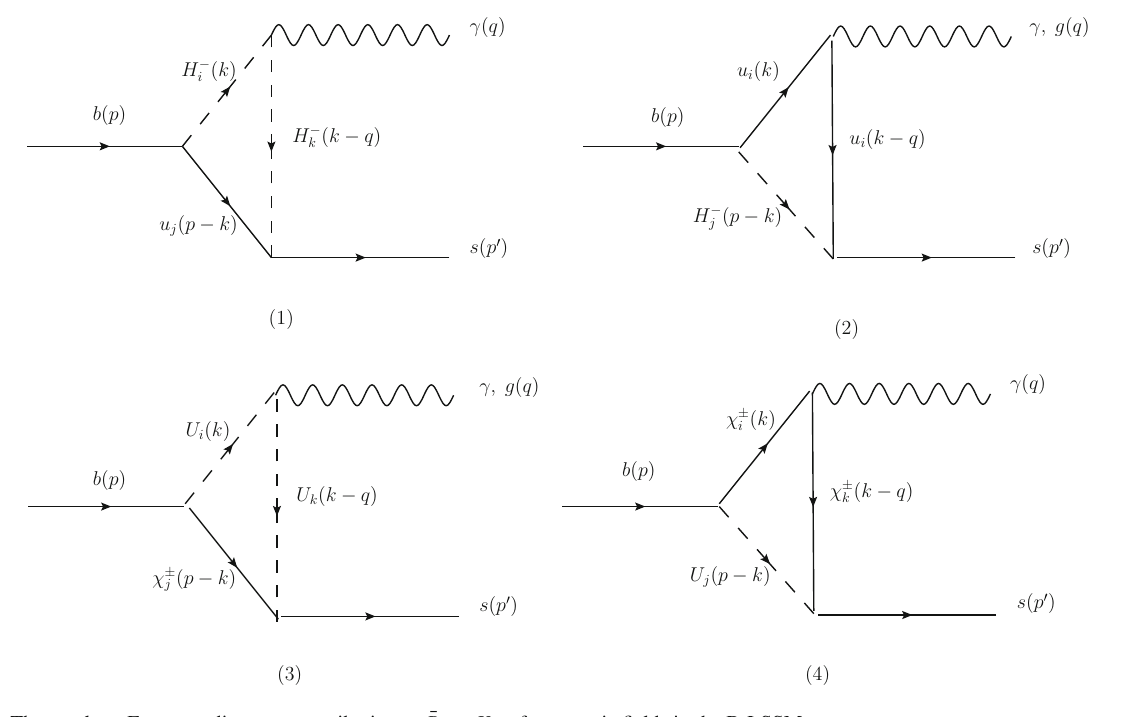
Fig. 1 The one loop Feynman diagrams contributing to ¯ B → X s γ from exotic fields in the B-LSSM